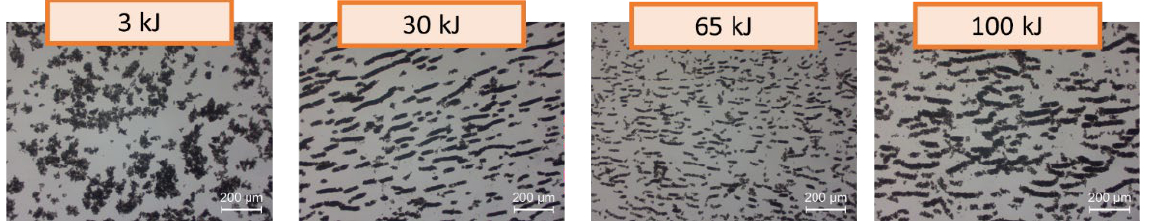
Figure 7. Optical microscopy images for MWCNTsCOOH at different ultrasonic energy levels (0.15 wt.% concentration).